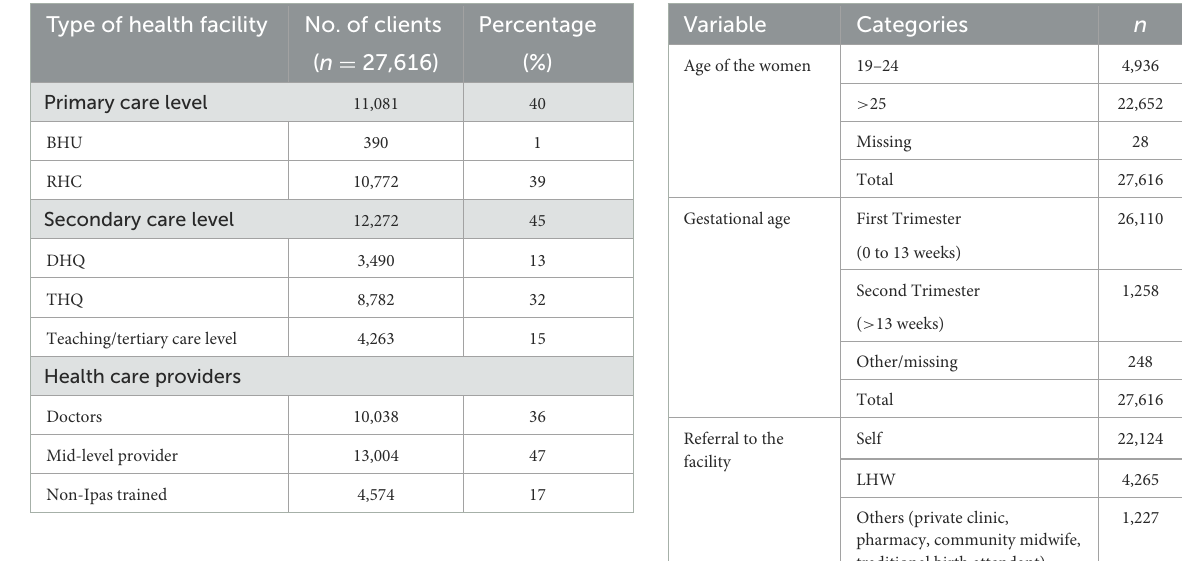
TABLE 2 Characteristics of women receiving PAC services at the health